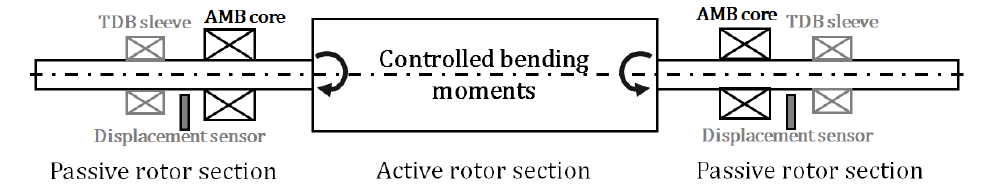
Figure 1. Rotor schematic including the Active Magnetic Bearings (AMBs), the Touch-down Bearings (TDBs), and the displacement sensor locations.